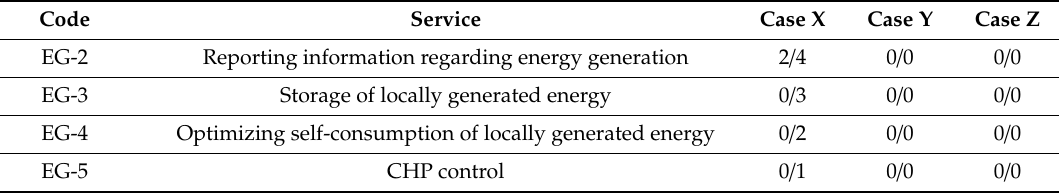
Table 9. The functionality levels in the main domain of energy generation (EG).